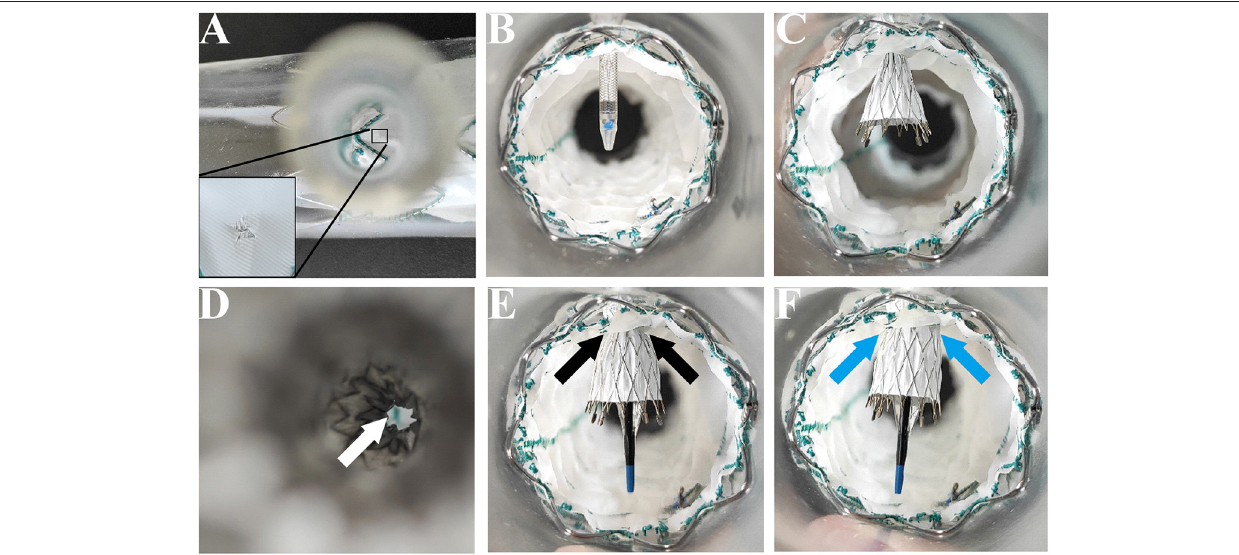
FIGURE 1 | In-vitro experiment on the MCPF stent grafts in silicone models. (A) Release of the Valiant Stent Graft (diameter 34mm and length 150mm) with a 5 × 5mm cross prefenestration (black square). (B) The hole of the fenestration is suitable to come through for an 8 Fr catheter delivery system (Fluency Plus Stent, diameter 80mm and length 80mm). (C) Release of the branch stent. (D) Top view of the branch stent after release. The hole was slightly expanded by the self-expanding force (white arrow). (E) The stent graft was flared with a peripheral angioplasty balloon at 4 atmospheres (Bard Mustang, diameter 10mm and length